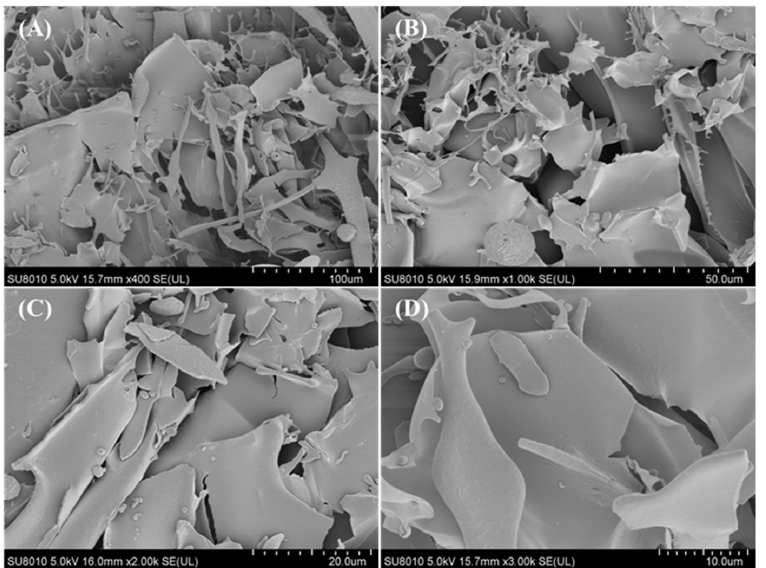
Figure 5. Scanning electron micrographs of EPS − 1 from Lc. citreum 1.2461. 400× ( A ), 1000× ( B ), 2000× ( C ) and 3000× ( D ).